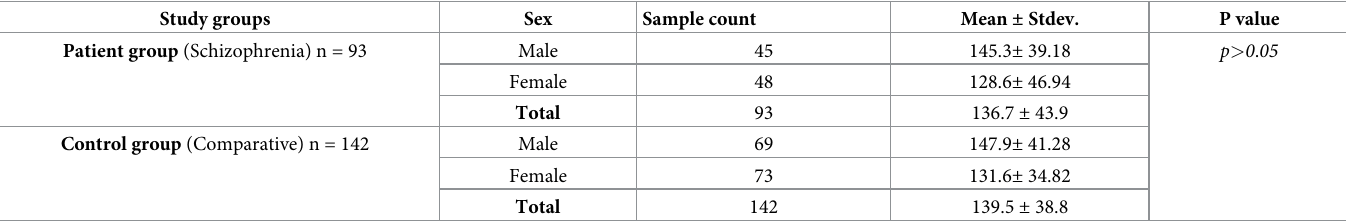
Table 4. Mean of total finger ridge